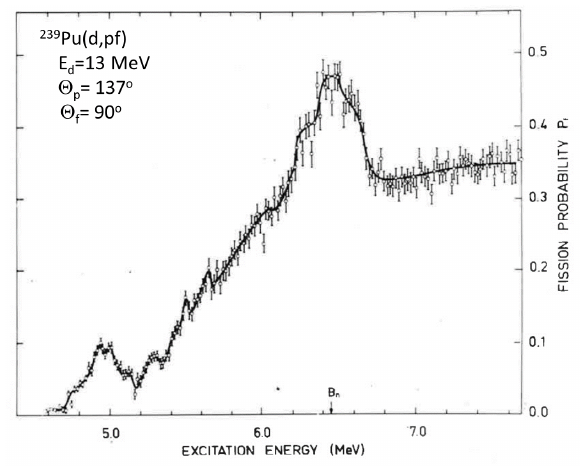
Figure 6. The fission probability for 239 Pu(d,pf) is shown as a function of excitation energy. The resonance at E X corresponds to a  -vibrational resonance in the second well near the top of the fission barriers